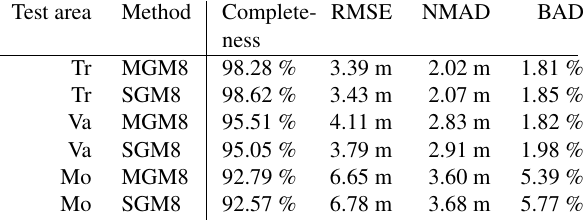
Table 4: SGM8 vs MGM8 evaluation on Cartosat-1 stereo pair. The BAD column gives the percentage of pixels with errors > 10 m.